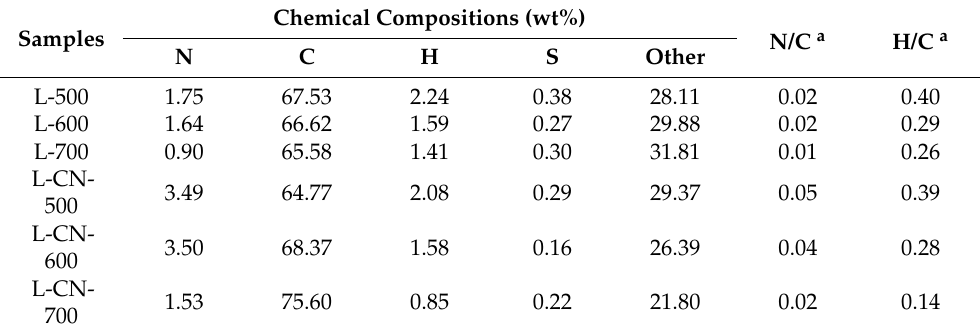
Figure 4. Raman spectra of the lignite-based porous carbons. Table 2. Chemical compositions of lignite-based porous carbons prepared at different activa- tion